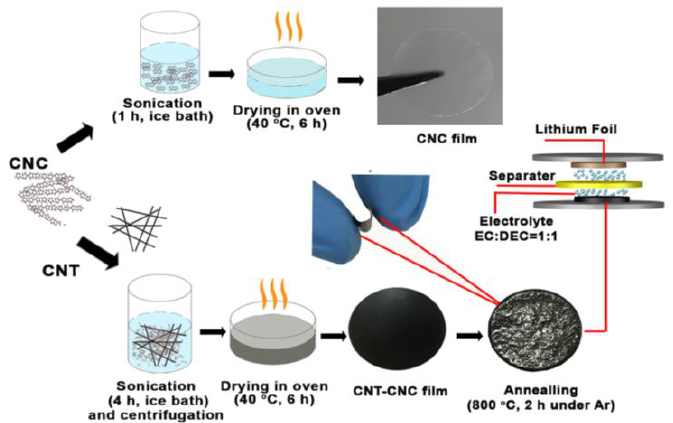
Figure 1. Schematic illustration of the free-standing electrode fabrication process.